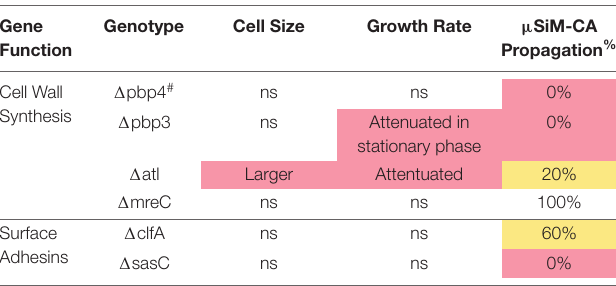
TABLE 1 | In vitro characterization of S. aureus deletion mutants across functional